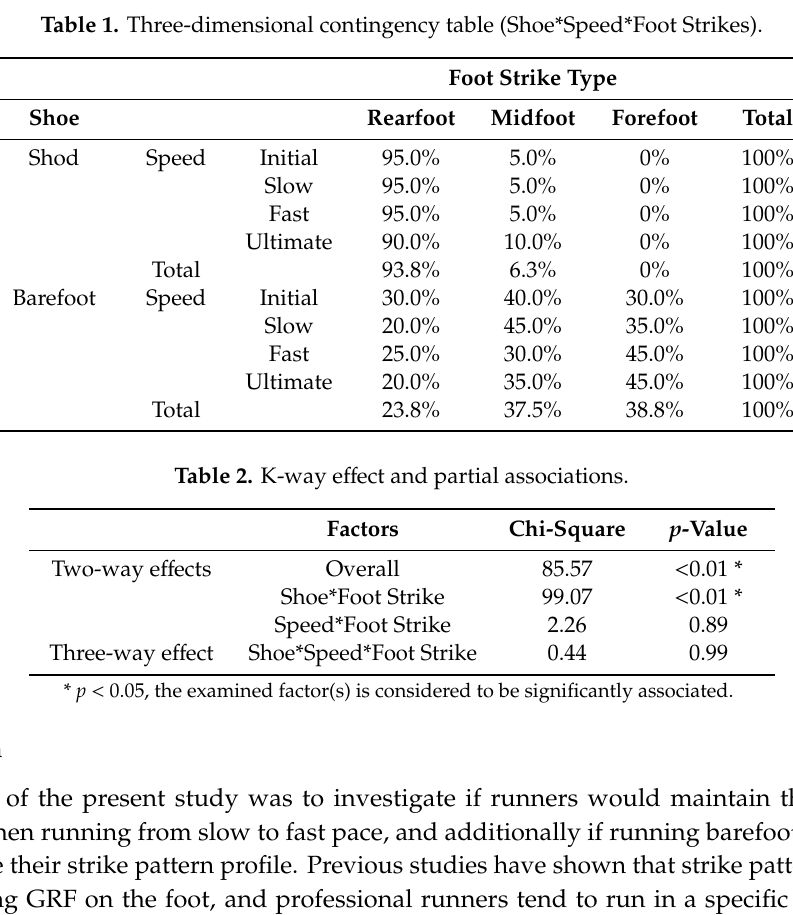
Table 2. K-way effect and partial associations.